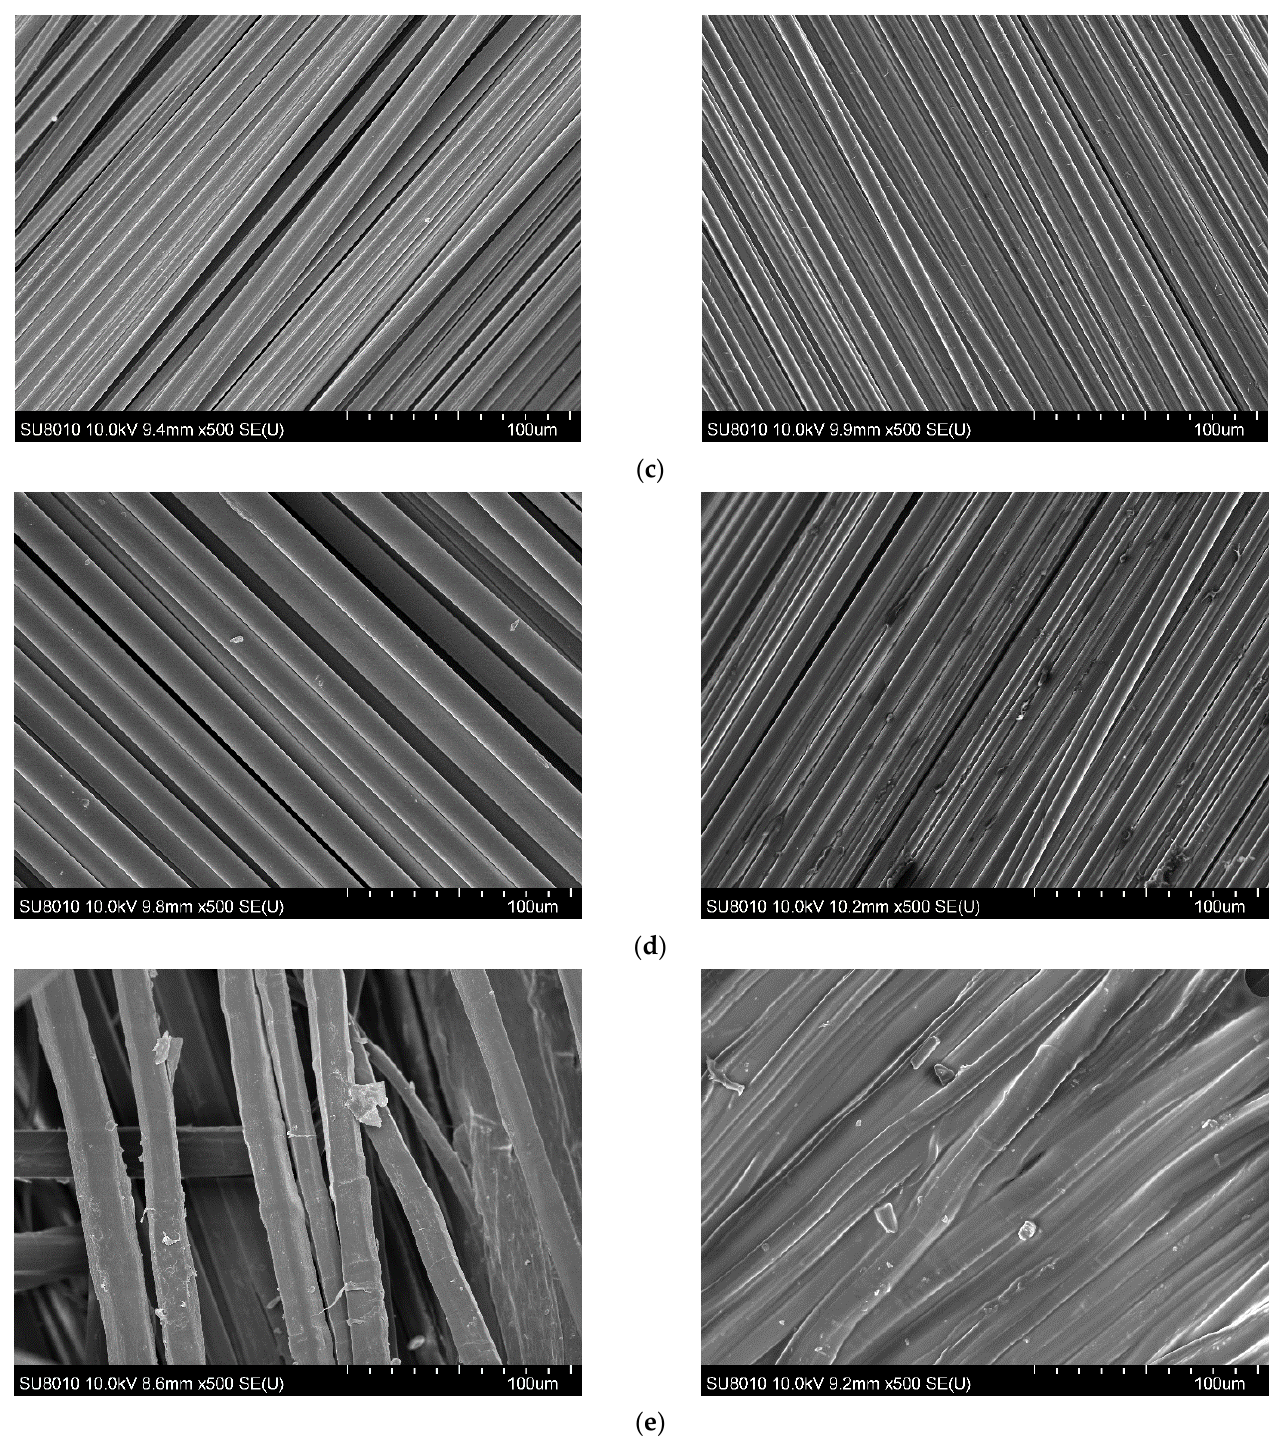
Figure 9. SEM images of G ( a ), A ( b ), C ( c ), B ( d ), and F ( e ) fabrics before CC tests (left column) and VGACBF composites after CC tests (right column).